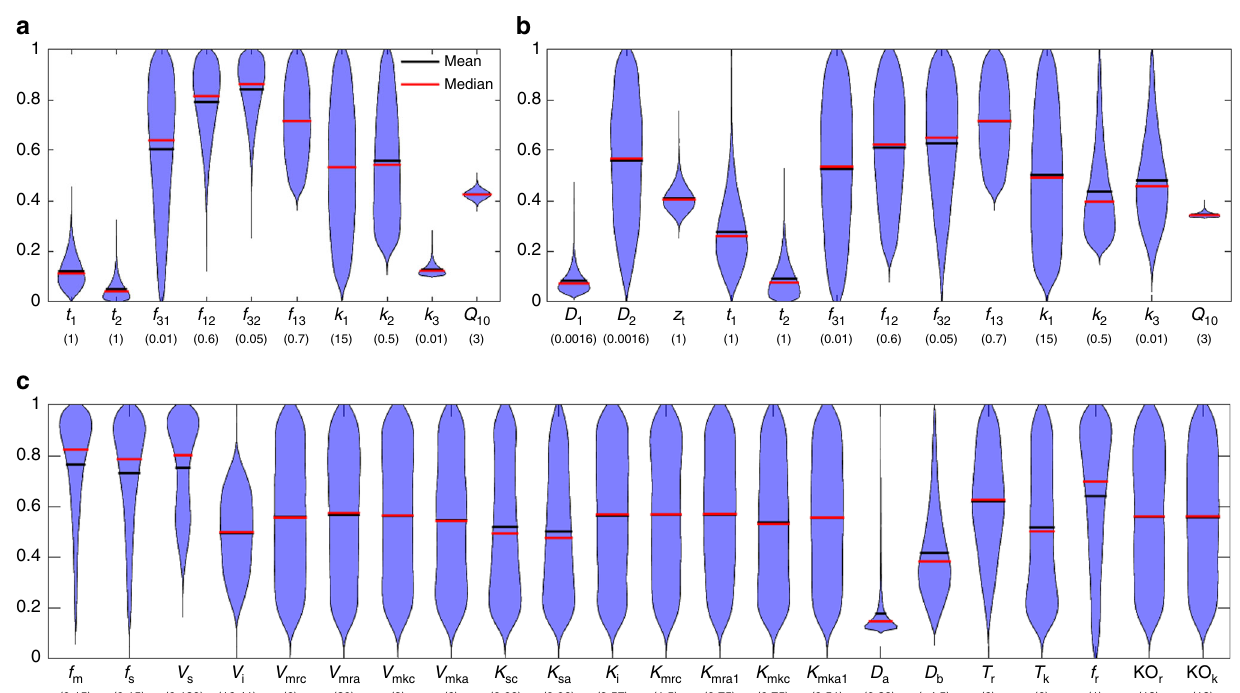
Fig. 2 Violin plot of the accepted model parameter values in the three decomposition models. a The conventional model; b the vertically resolved model; c the microbial model (MIMICS). The narrower distributions of the parameters suggest that they are better constrained. For posterior distribution of each parameters, please refer to Supplementary Figs. 4, 5, and 6. For meanings of parameters, refer to Tables 1, 2, and Supplementary Table 1. Note that the values on the y -axis are normalized to the range of [0, 1] by the corresponding values in the brackets under each parameter. In the other words, the real values can be derived by multiplying the values in the